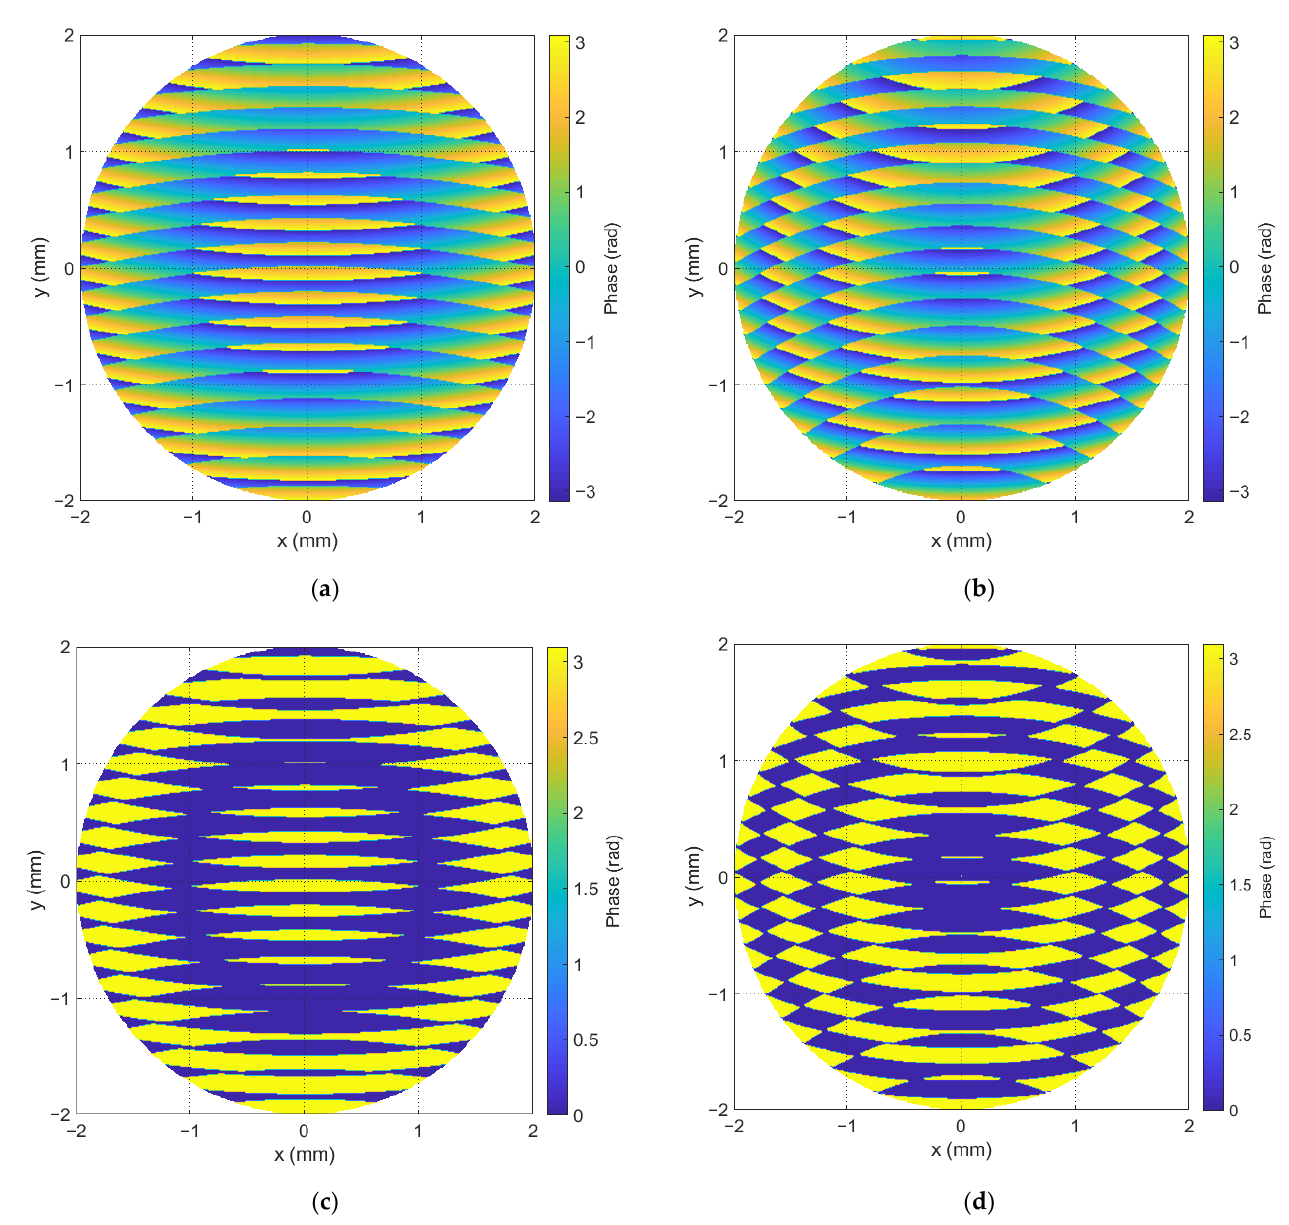
Figure 4. Distribution of the phase argument of the CGH with the value of the weight coefficient in the reference beam: ( a ) 0.53λ for grayscale Fourier CGHs; ( b ) 1.33λ for grayscale Fourier CGHs; ( c ) in the reference beam: ( a ) 0.53 λ for grayscale Fourier CGHs; ( b ) 1.33 λ for grayscale Fourier CGHs; 0.53λ for binary Fourier CGHs; ( d ) 1.33λ for binary Fourier CGHs. ( c ) 0.53 λ for binary Fourier CGHs; ( d ) 1.33 λ for binary Fourier